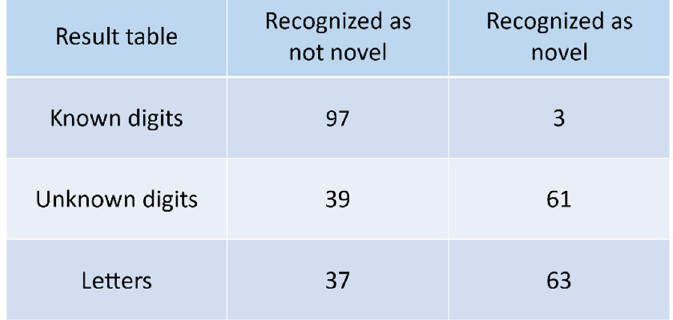
Figure 5. Performance of simple classification network for novelty detection.